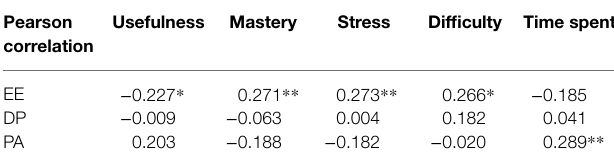
TABLE 6 | Pearson correlation between burnout and dental clinical